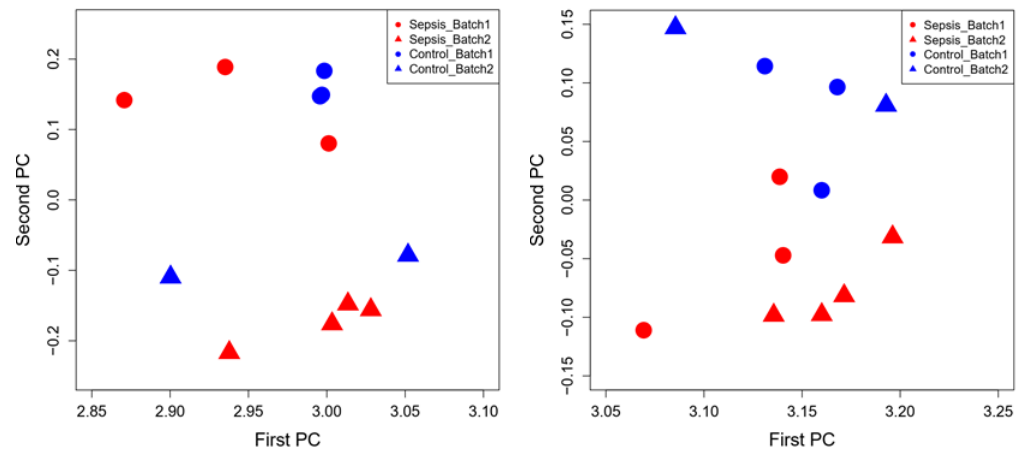
Figure 3. Plot of first two batches from Principal Component Analysis (PCA) of 261 proteins before ( A ) and after ( B ) batch correction. Blue color indicates controls and red color indicates sepsis. Circle represents first batch and triangle represents second batch. Before batch correction ( A ), patients in first batch (circle) are clearly separated from patients in second batch (triangle).